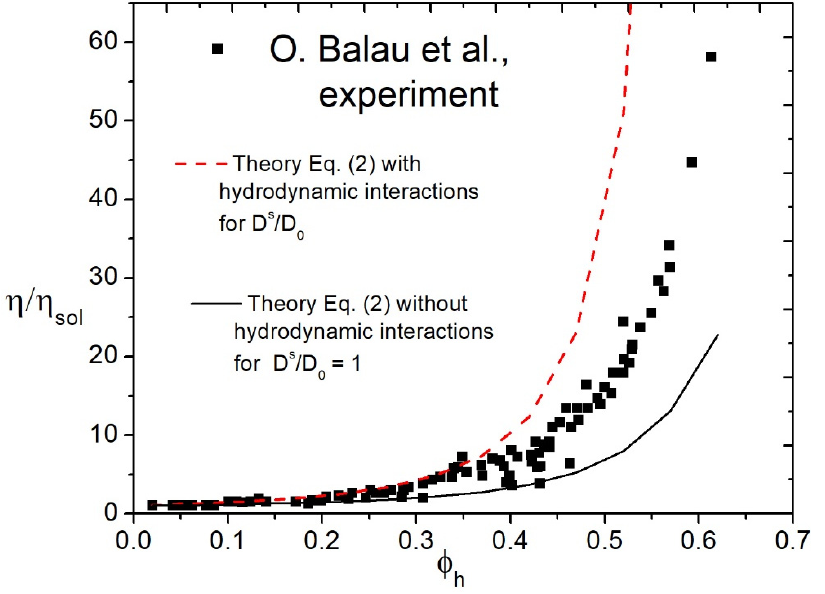
Figure 7. Comparison of the relative bulk viscosity as a function of the hydrodynamic concentration of magnetic particles in the fluid against the experimental data (symbol ∎ ) taken from Balau O. et al. [5]. Calculations of the colloid viscosity use Equation (2) with the structure factor given by the analytical mean spherical approximation and soft repulsion of the Weeks–Chandler–Andersen potential, as explained in the text.